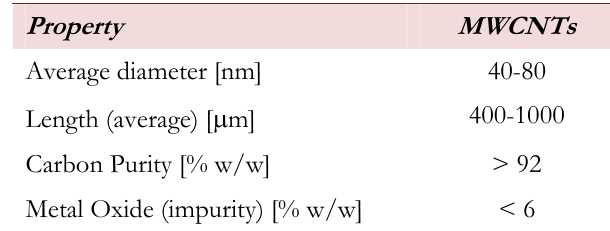
Table 1: Features of the MWCNTs dispersed in the cement